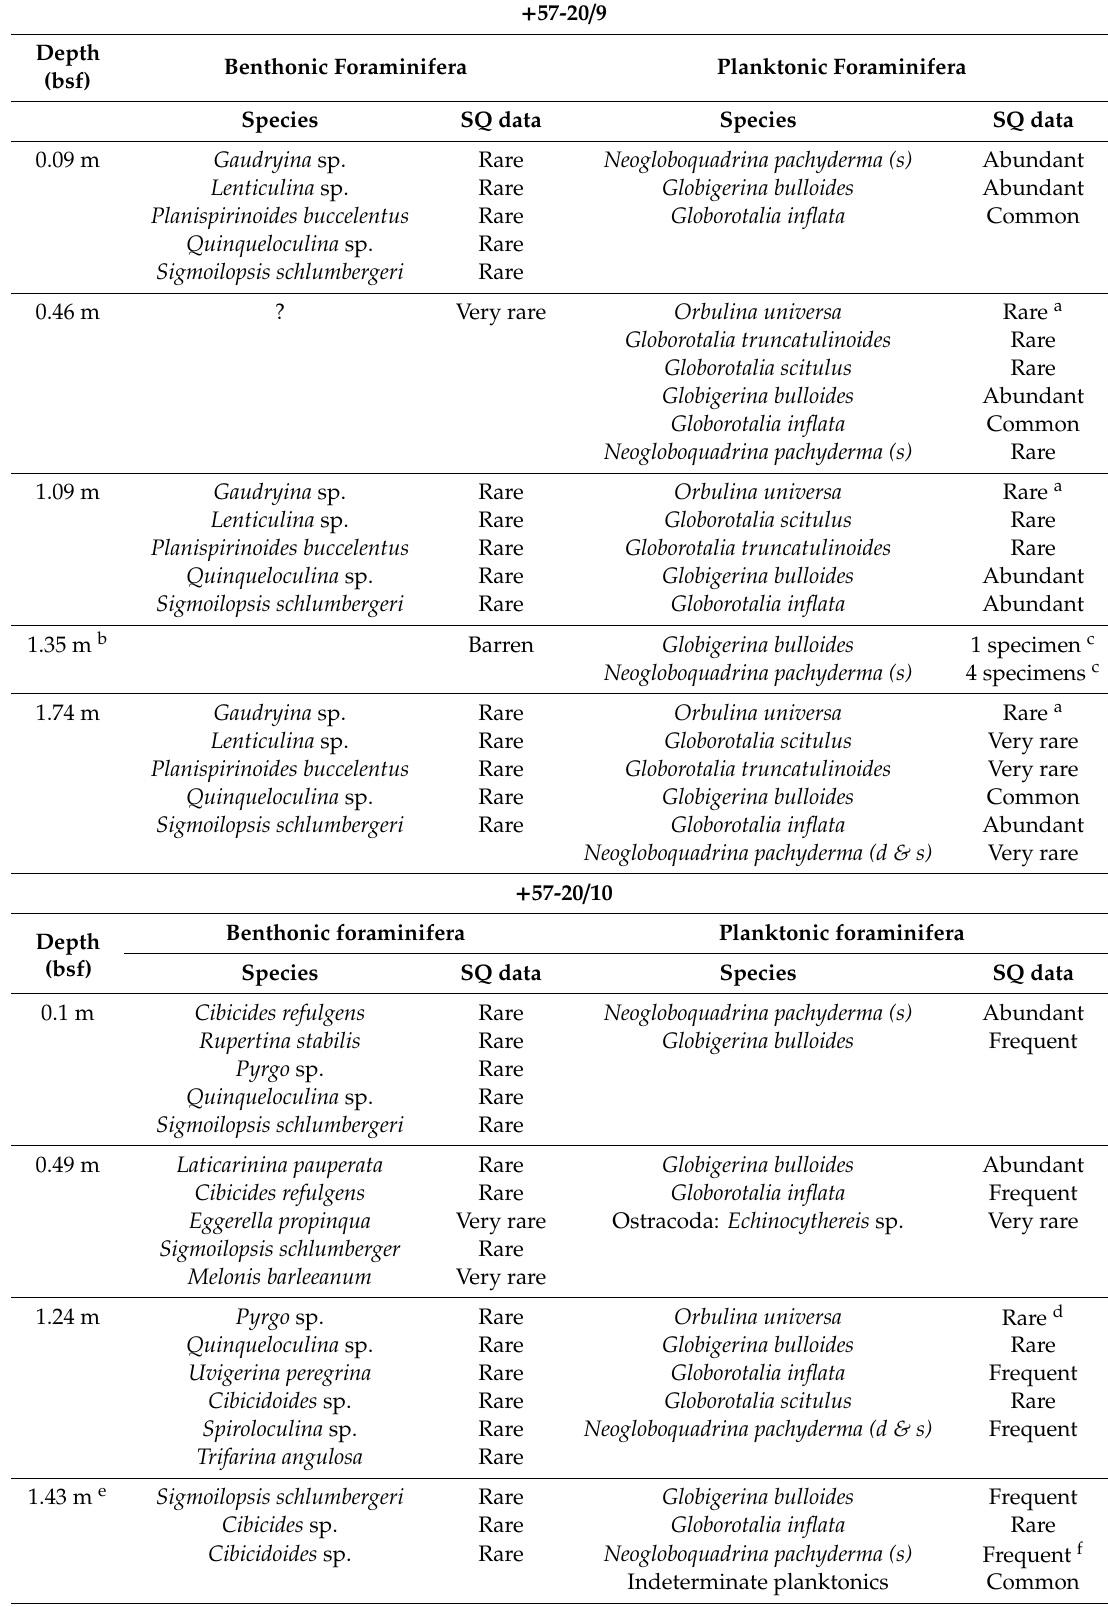
Table 2. Distribution of microfossils in cores + 57-20 / 9 and + 57-20 / 10 (based on BGS internal report [54]). SQ: